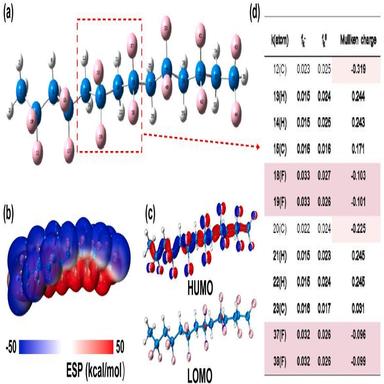
DFT calculation for PVDF molecule (7 single units as an example) at B3LYP/6–31 G level: (a) molecular structure; (b) electrostatic potential surfaces (c) the molecular HOMO and LUMO and (d) Fukui index (fk - and fk 0 ) and Mulliken charge of PVDF.